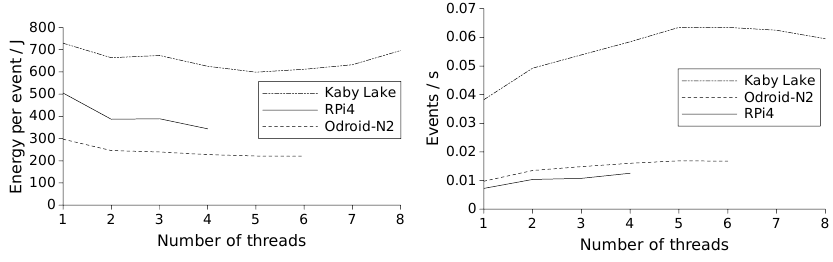
Figure 3. The energy / event and processed events / s as a function of number of threads for the ARM